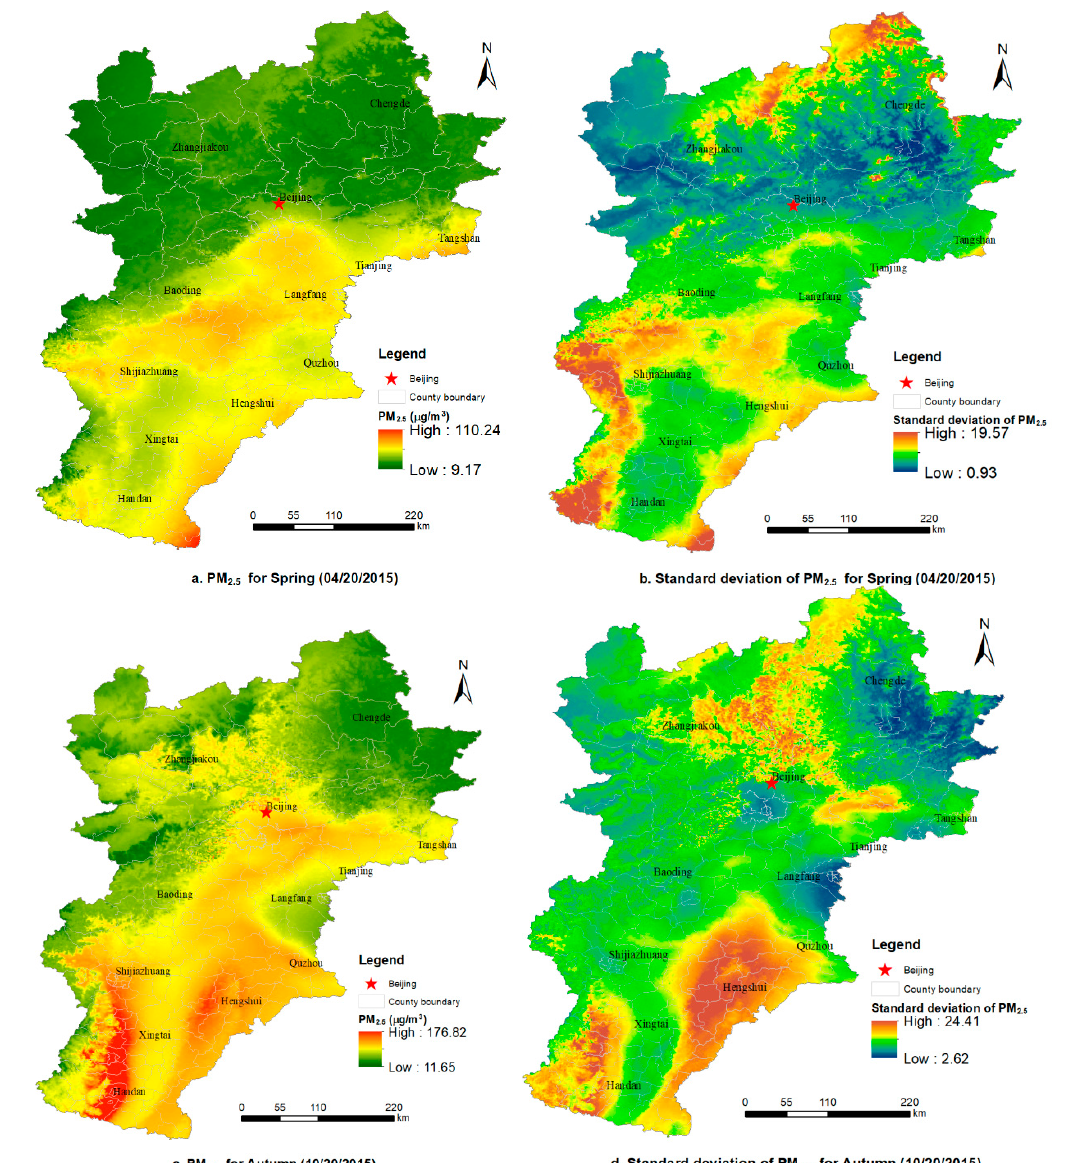
Figure 9. Grid surfaces of predicted PM 2.5 ( μ g/m 3 ) (( a , c )) and its standard deviation (( b , d )) for two seasonal days (( a , b ): spring; ( c , d ): autumn) in 2015. Ensemble-predicted PM 2.5 grid surfaces obtained by XGBoost are presented in Supplementary Figure S11. Despite similar spatial distributions on a large scale, PM 2.5 predictions from XGBoost showed problematic results (i.e., abrupt and unrealistic variations) at certain locations on a local